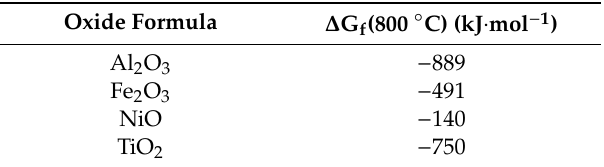
Table 6. Gibbs energy of formation ( ∆ G f ) of selected oxides at 800 ◦ C recalculated to one mol of oxidized metal